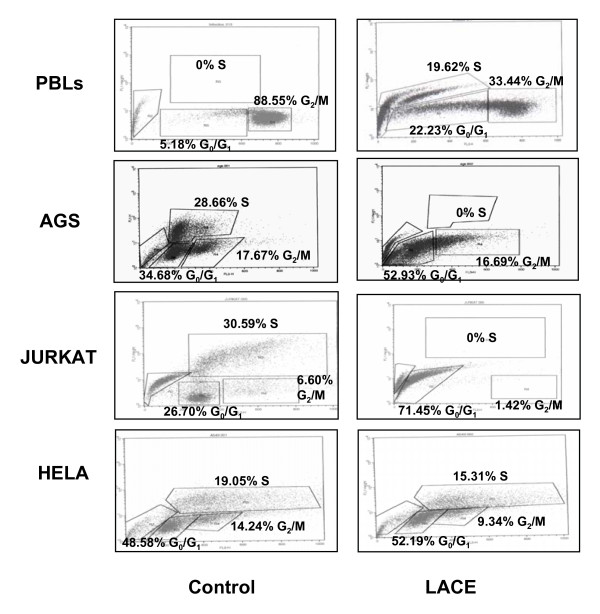
Cell cycle analysis of cells treated with LACE. PBLs were treated with LACE for 96 h, and cells were analyzed by flow cytometry. Similarly, tumor cell lines were treated with LACE for 96 h. Data indicate the percentage of cells in each phase of cell cycle. Results are representative of three independent experiments.